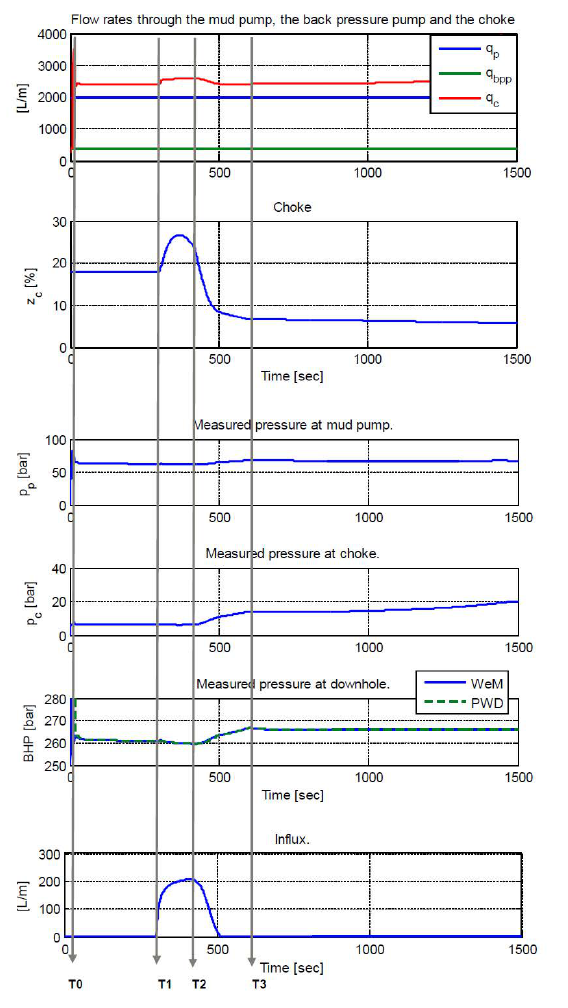
Figure 4: Case 2: Flowrates, choke opening, measured pressure and Influx flow rate using AKC on Well